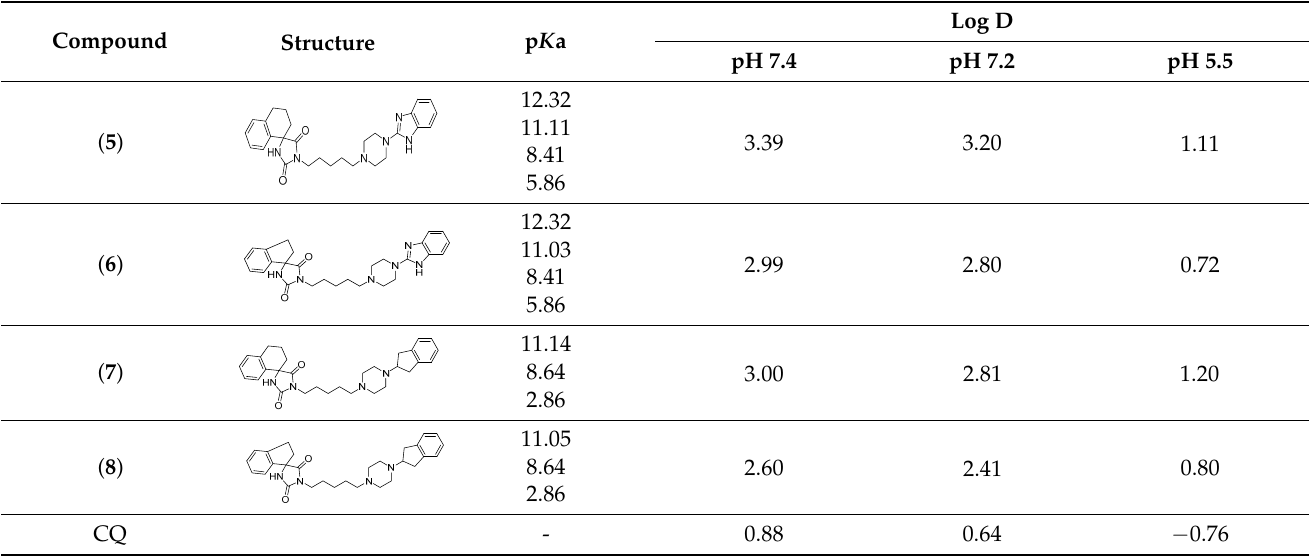
Table 2. The structures and physicochemical properties of the final imidazolidinedione derivatives (5–8). Compound